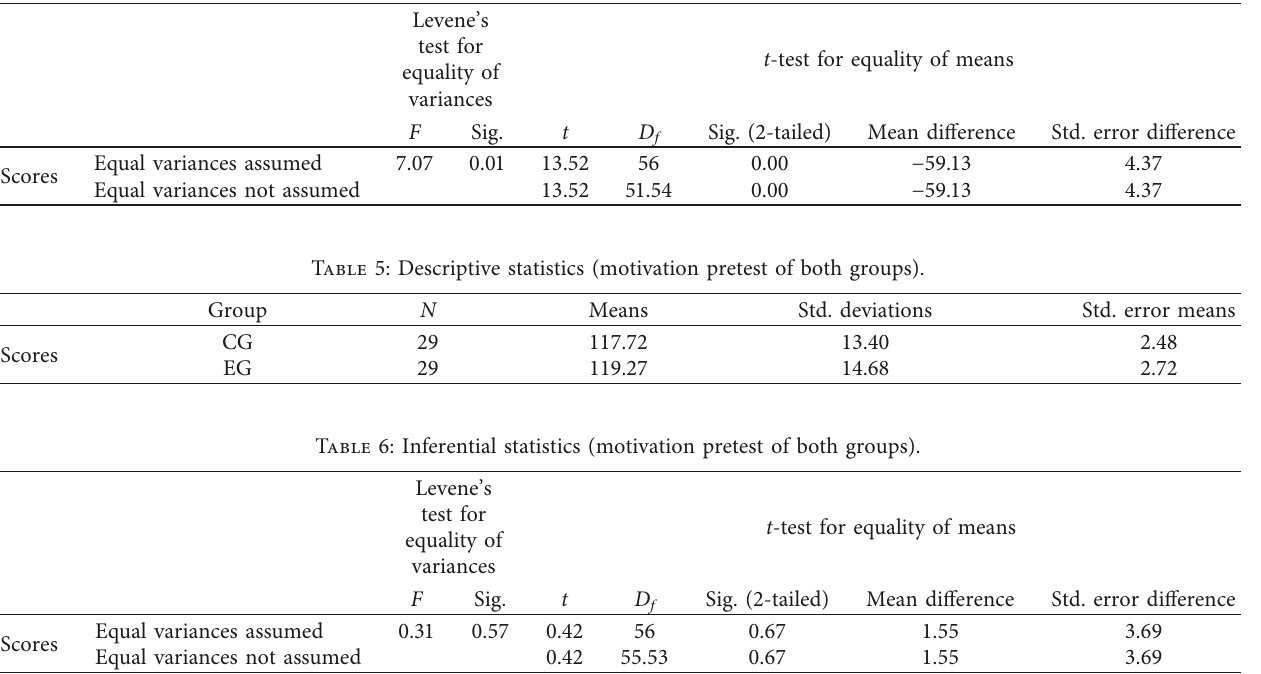
Table 4: Inferential statistics (anxiety post-test of both groups).